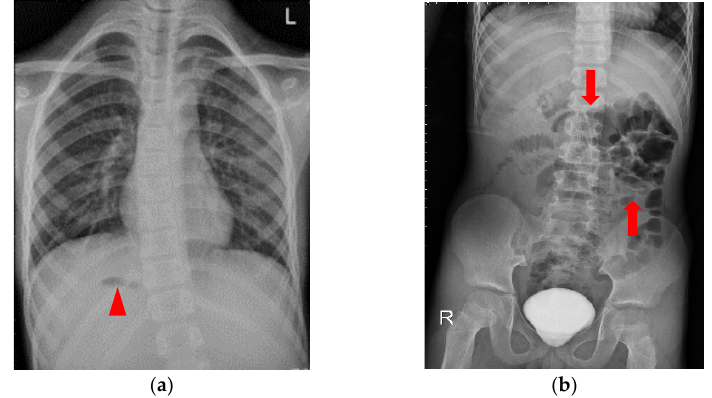
Figure 2. Plain film of the chest and abdomen: ( a ) right-sided stomach gas (arrow head) and levocardia; ( b ) midline liver shadow and colon gas on the left side (arrows), suggesting heterotaxy syndrome and malrotation. Contrast medium that had not finished metabolism was retained in the urinary bladder.